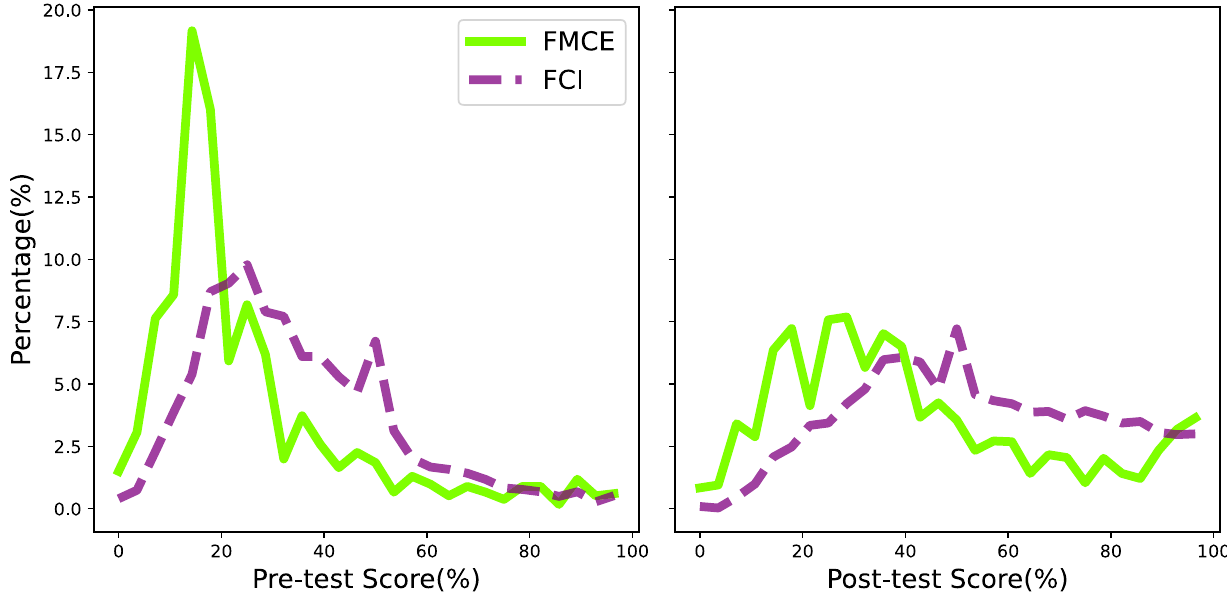
FIG. 2. Distribution of pre- and postscores for FCI and FMCE courses from the LASSO dataset ( N ¼ 6688 ). In both the pre- and postscore cases, the distribution of scores are right skewed normally distributed. Data come from multiple institutions across multiple ¼ 90 courses ( N courses